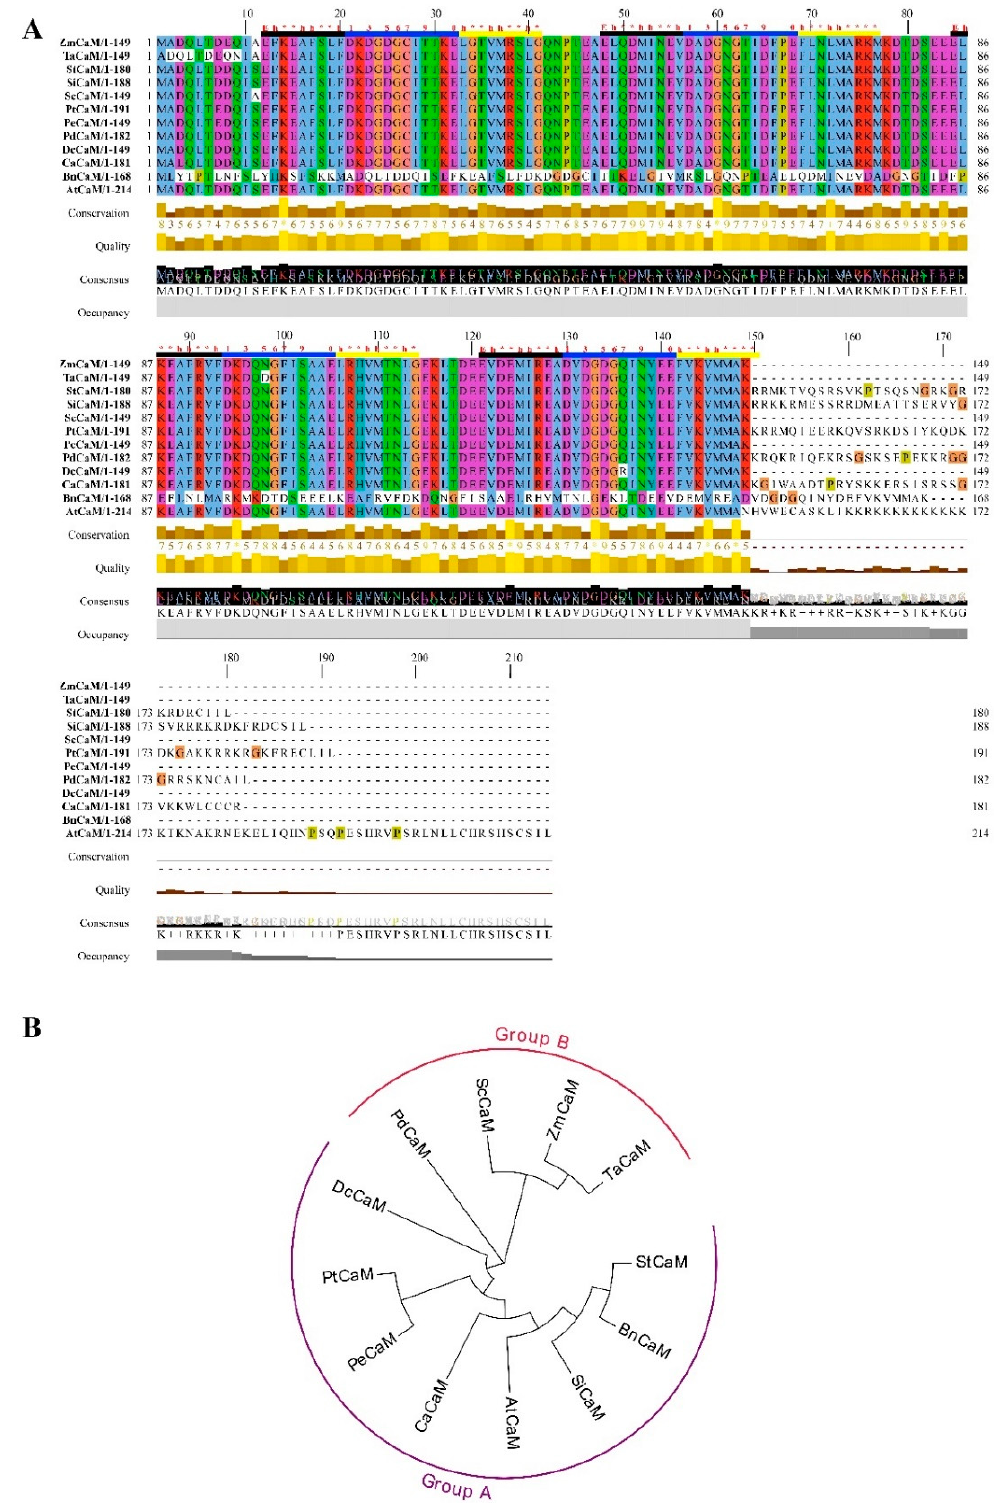
Figure 2. The sequence homology and phylogenetic analysis. ( A ). Sequence homology analysis of ScCaM and the other 11 CaMs from other plant species. The black, blue, and yellow rectangles represent the E-helix, loop, and F-helix, respectively. “h” represents hydrophobic amino acids and “*” represents any amino acid. ( B ). Phylogenetic analysis of CaM proteins from 12 plant species. All the corresponding GenBank accessions are listed in Table S2.